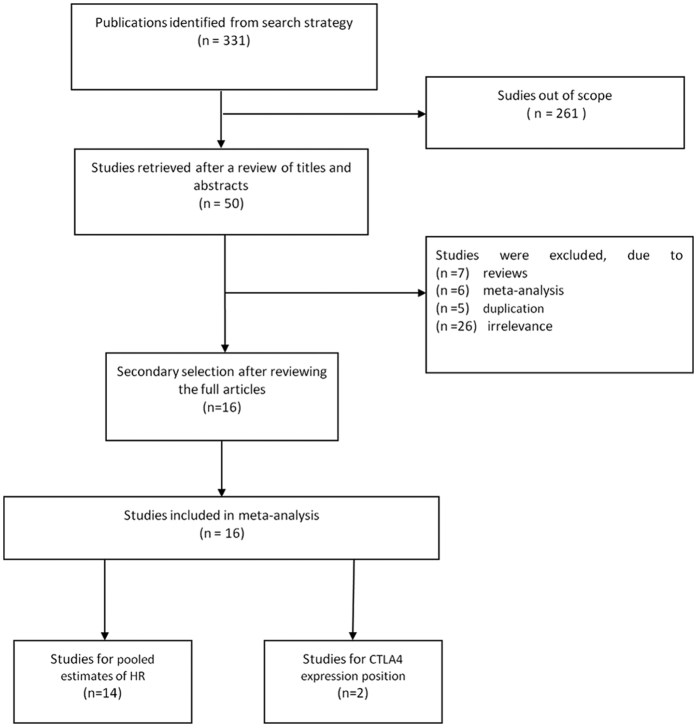
Meta-analysis flow chart.